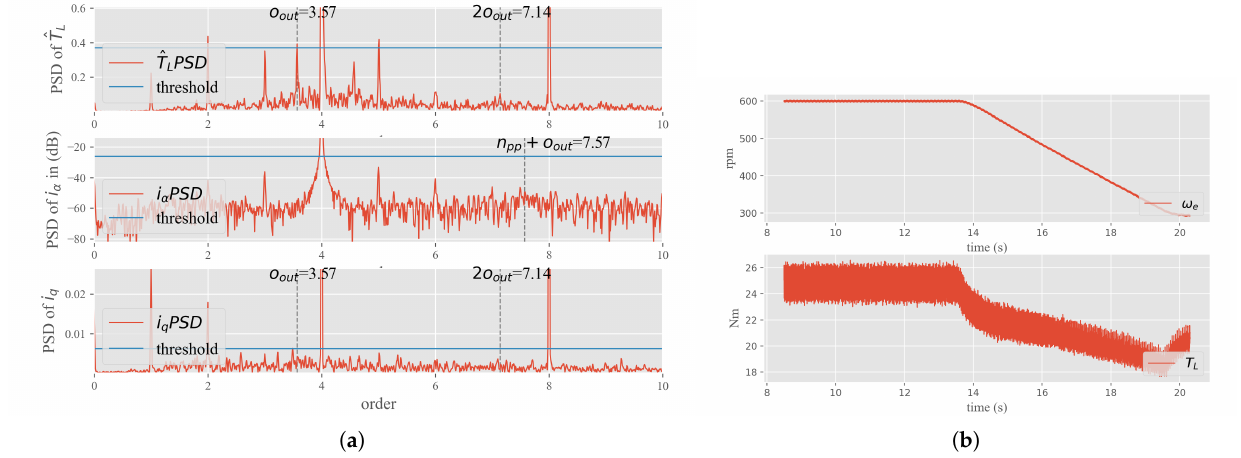
Figure 9. Speed varying experiments (Case2) of the bearing fault motor ( a ) power spectrum density and ( b ) graphical transients of speed and